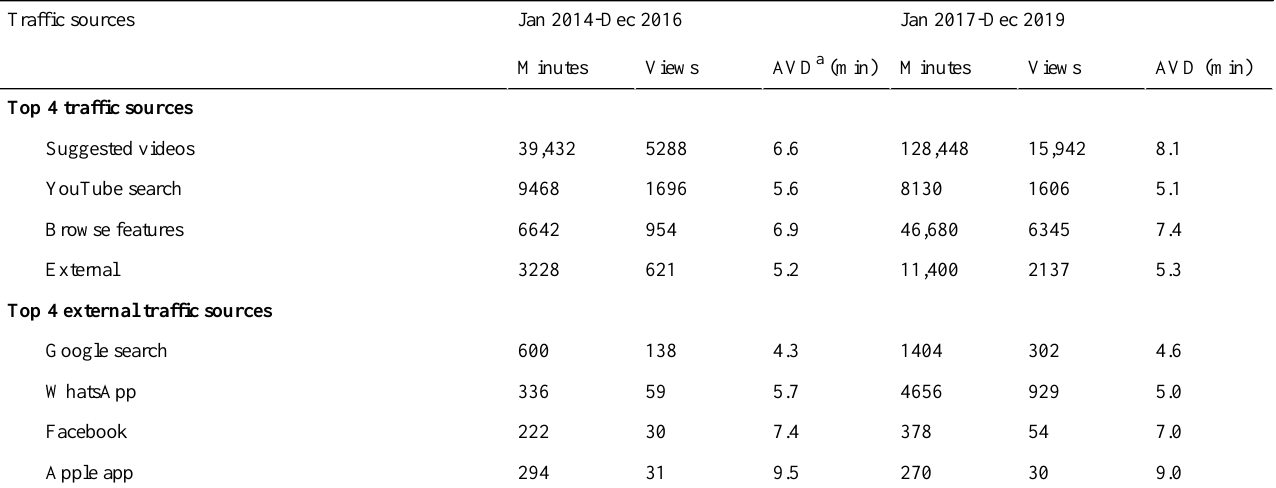
Table 2. Traffic sources.